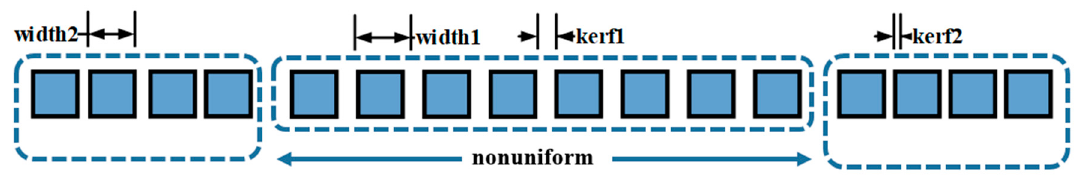
Figure 12. The schematic of the home-made MNULA. Table 2. The structural parameters of the laboratory-made transducer. Structural Parameters